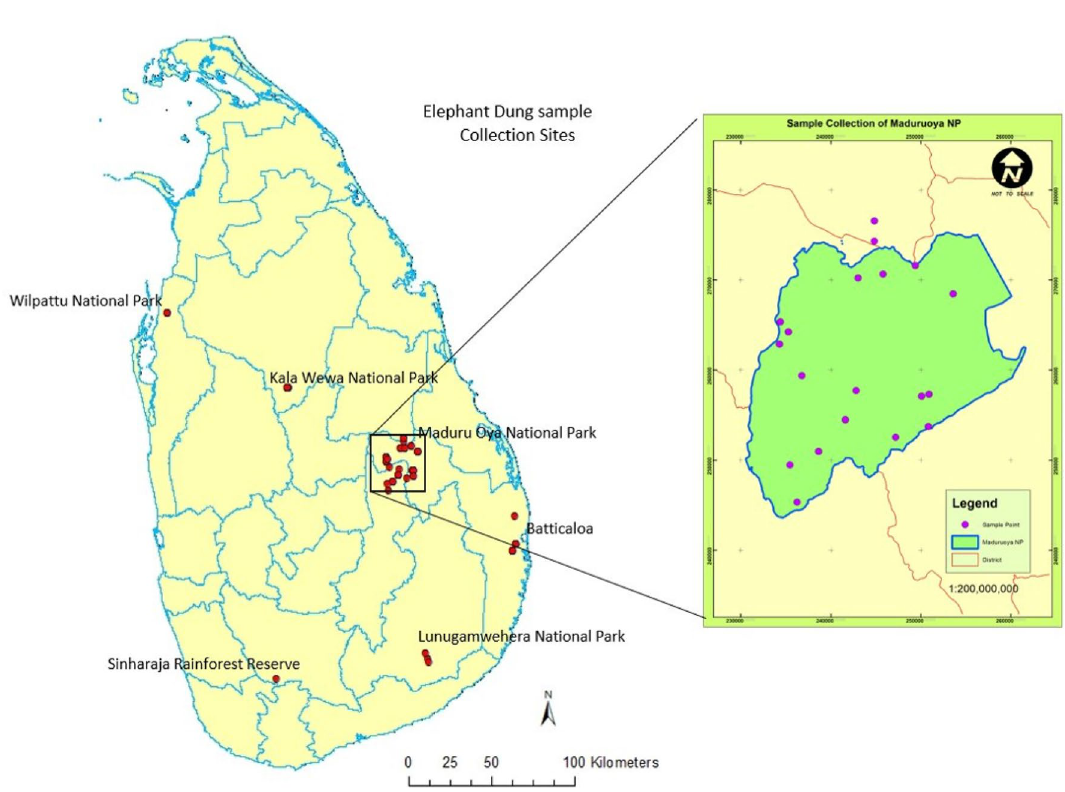
Figure 3. Distribution of wild elephant dung sampling sites in Sri Lanka. The number of dung samples collected varied and decided in proportion to the number of elephants in a considered population. A total of 93 samples were collected covering most of the National Parks in Sri Lanka from wild